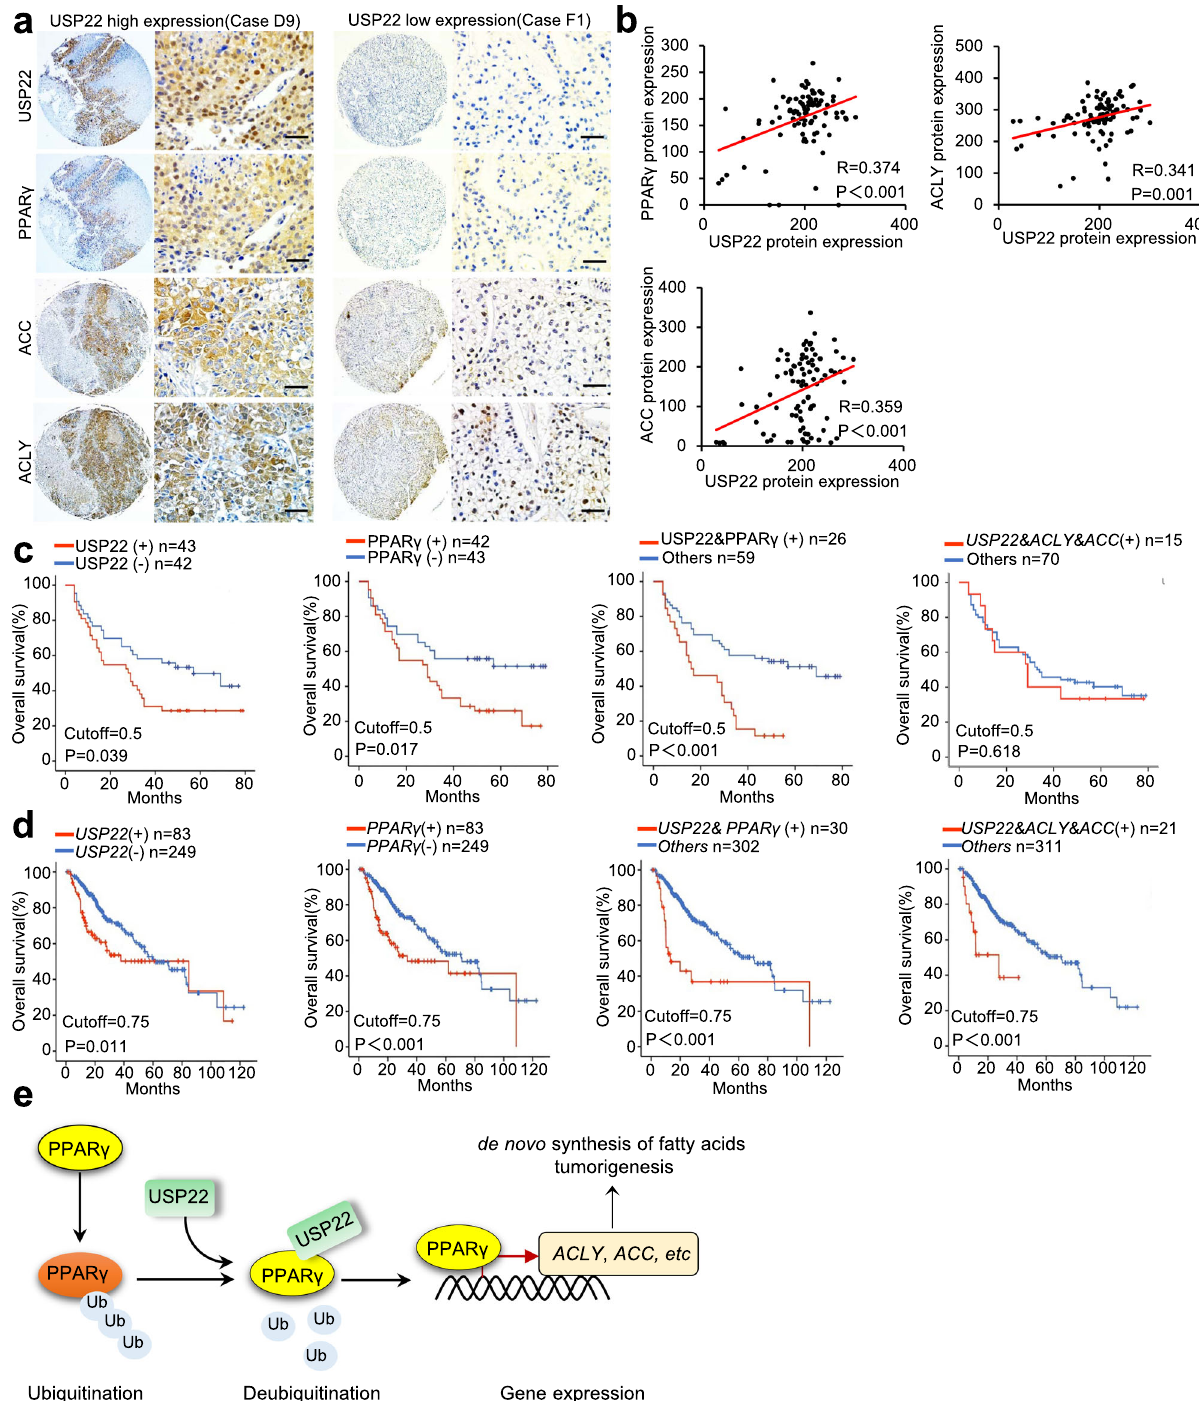
Fig. 8 The USP22 – PPAR γ /ACC/ACLY axis contributed to HCC prognosis. a Representative IHC staining of USP22, PPAR γ , ACC, and ACLY in HCC TMAs (HLivH180Su11, contains prognosis information, Shanghai Outdo Biotech Company). Scale bars, 50 μ m. b Correlation analysis between USP22 and PPAR γ , ACC, ACLY protein expression based on H-Score in HCC TMAs (HLivH180Su11). R represents the Pearson correlation coef fi cient. c Kaplan – Meier curves of the survival analysis of USP22-positive, PPAR γ -positive, USP22& PPAR γ copositive, and USP22&ACC&ACLY copositive patients based on HCC TMAs prognosis data (HLivH180Su11). d Kaplan – Meier curves of the survival analysis of USP22 -positive, PPARG -positive, USP22 & PPARG copositive, and USP22 & ACACA & ACLY copositive patients based on the prognosis data of TCGA LIHC database. e Diagram of the proposed mechanism. Source data are provided in the Source Data fi